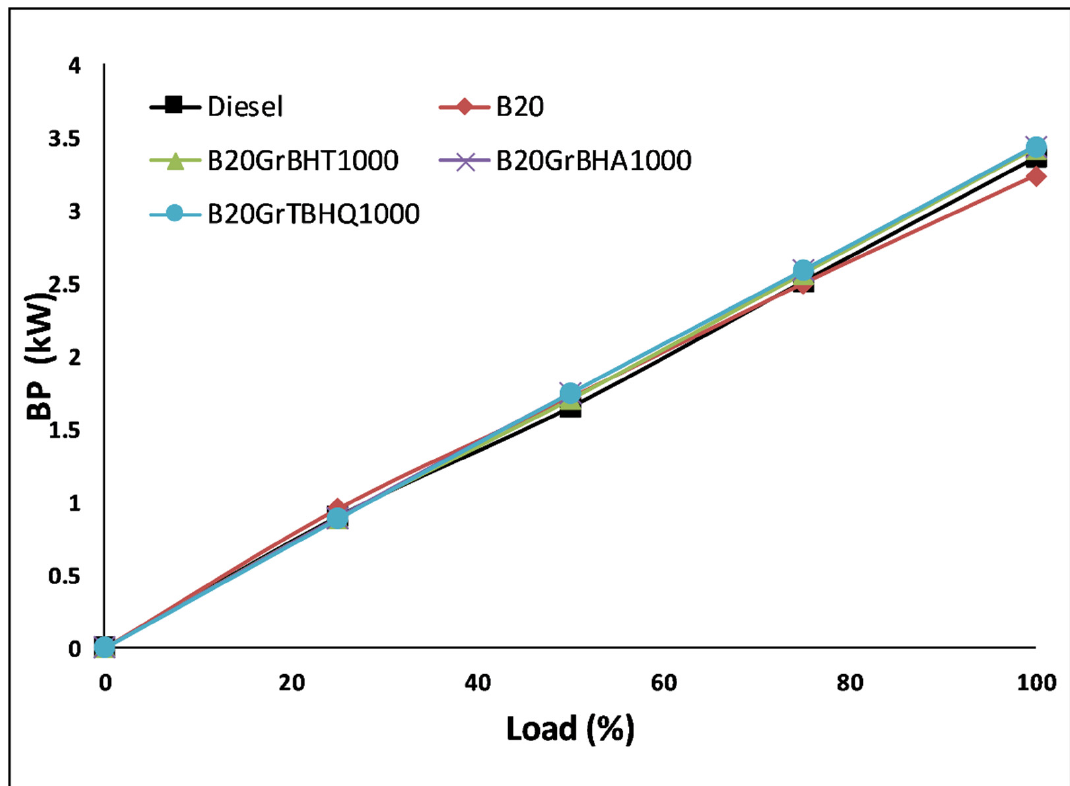
Figure 2. Deviation of brake power with load .